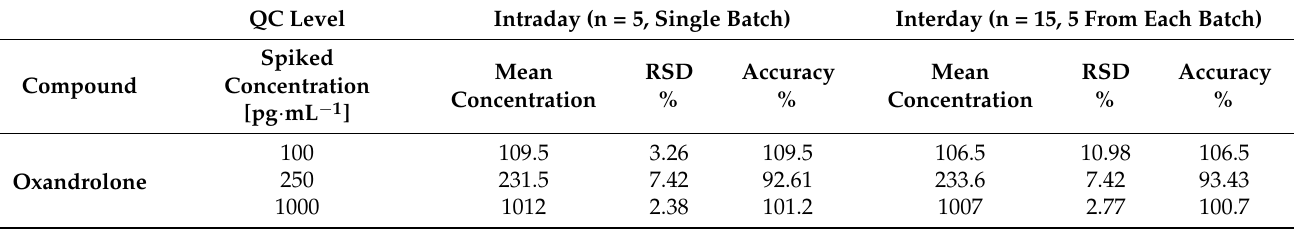
Table 3. Intra- and Interday accuracy and